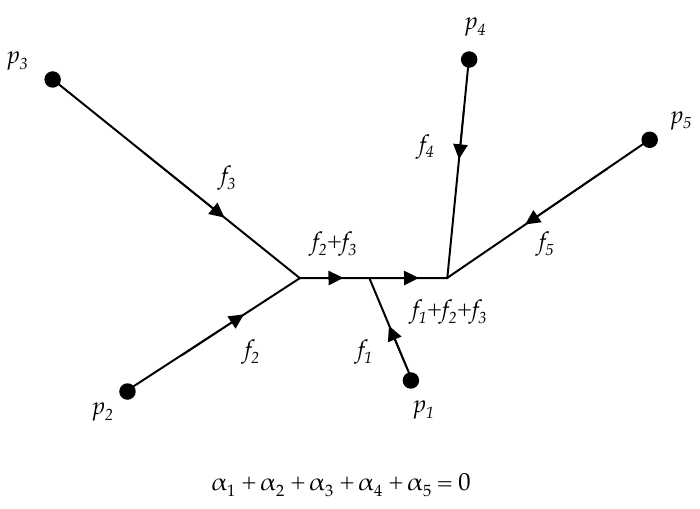
Figure 9 . A gradient (cid:13)ow tree with 5 external vertices of Morse index 1.